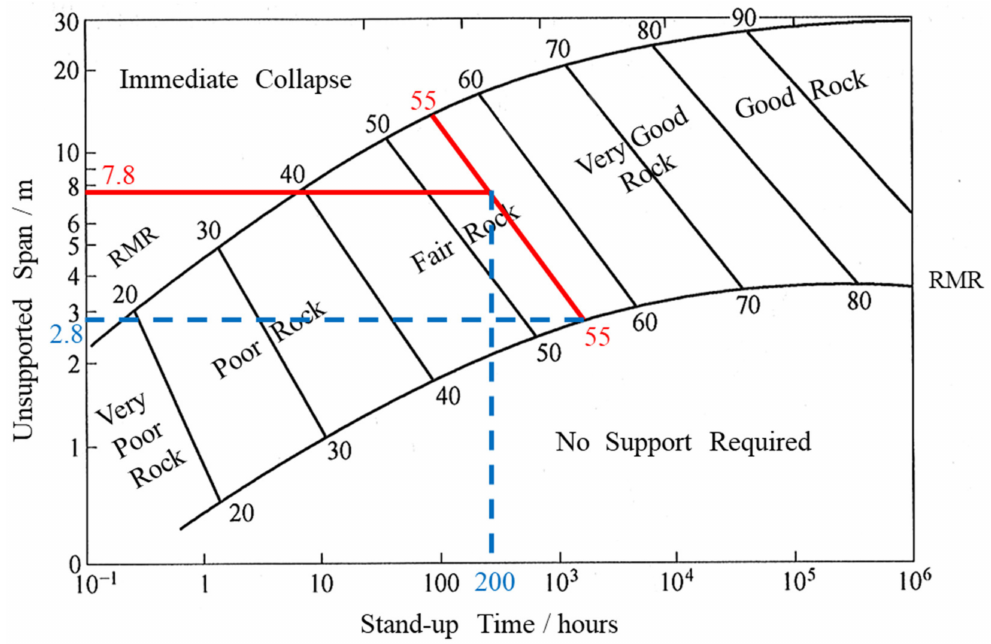
Figure 5. Maximum self-stabilization span and time of unsupported rock mass based on